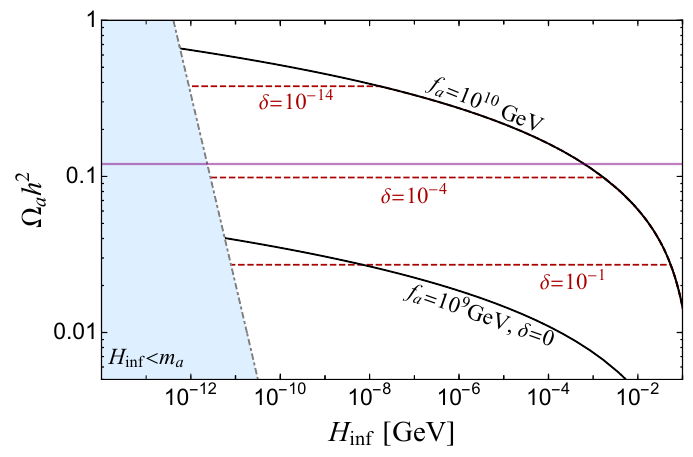
Figure 2 . (cid:10) a h 2 with the initial misalignment angle (2.12) and (cid:14) = 0, as a function of H inf for f a = 10 9 and 10 10 GeV. We also show the cases of (cid:14) = 10 (cid:0) 1 ; 10 (cid:0) 4 ; 10 (cid:0) 14 for f a = 10 10 GeV in red dashed lines, from bottom to top. In the left blue shaded region, the axion is not light, i.e., m a ( T inf ) > H inf , and our analysis cannot be applied. The narrow horizontal purple band represents the observed DM